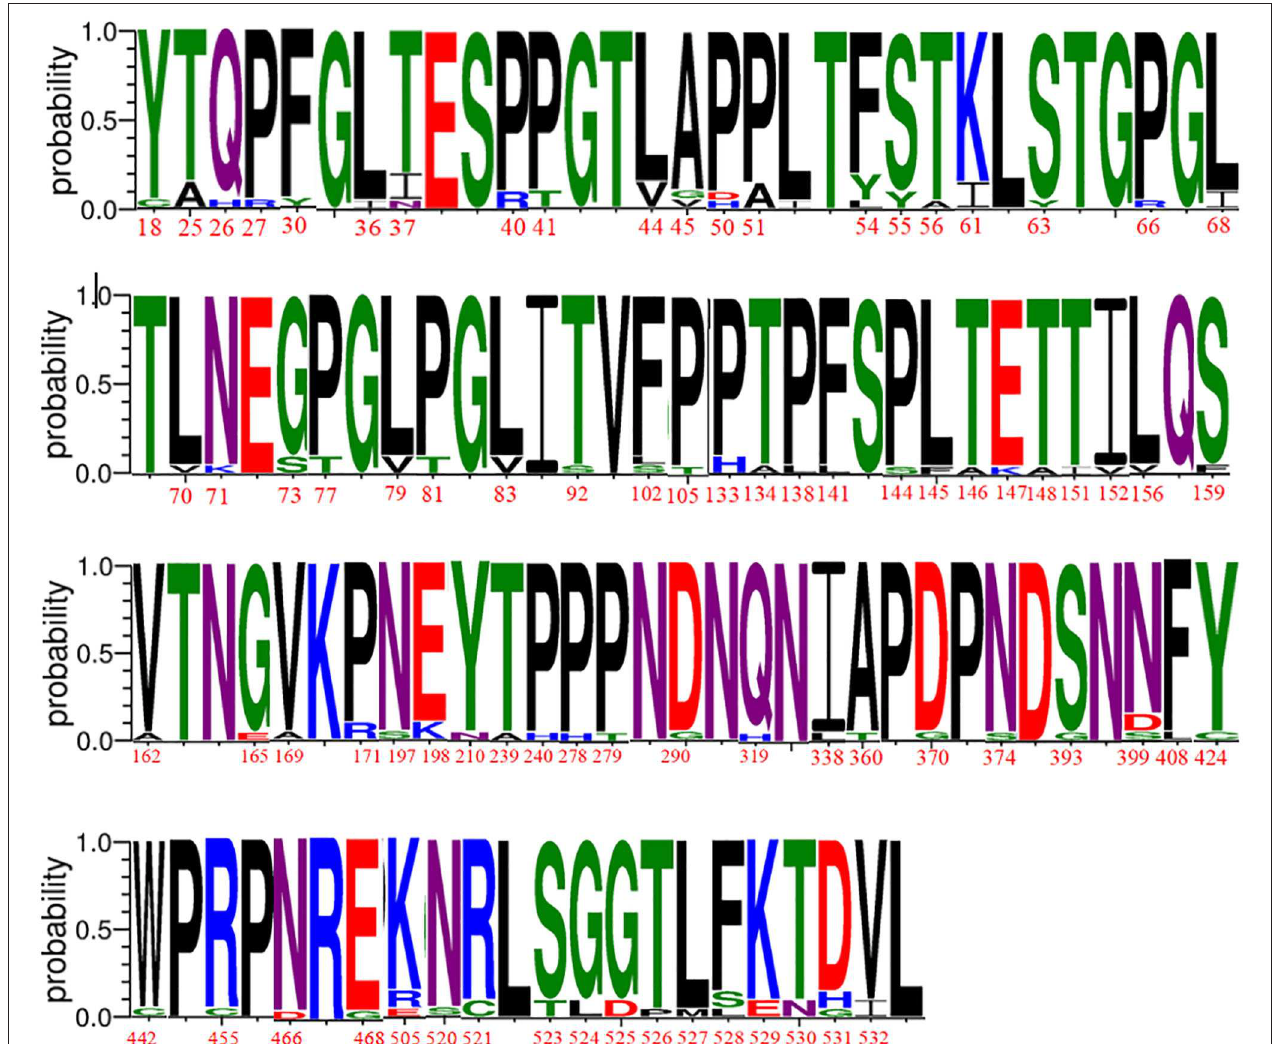
FIGURE 2 | Divergence analysis of fiber proteins of CAdV-2 strains identified in our